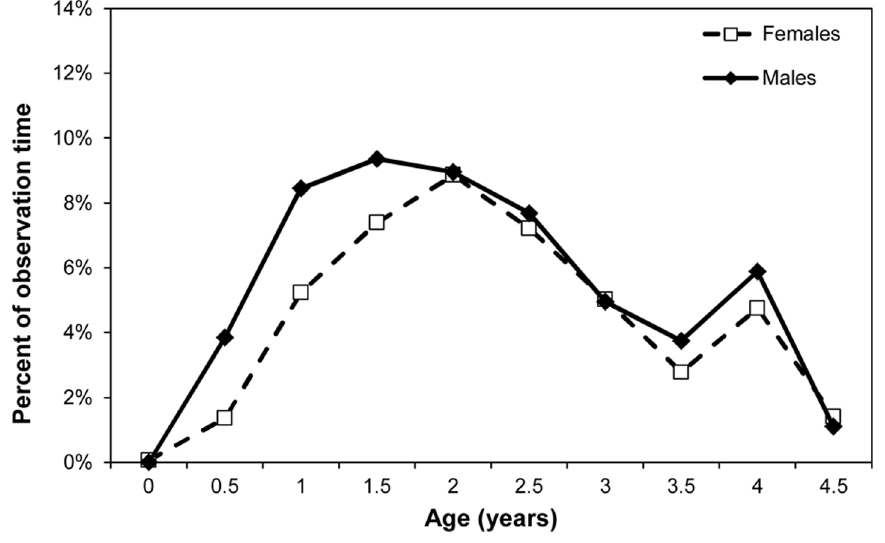
Figure 4. Mean percent of observation time spent riding dorsally for male and female infants.